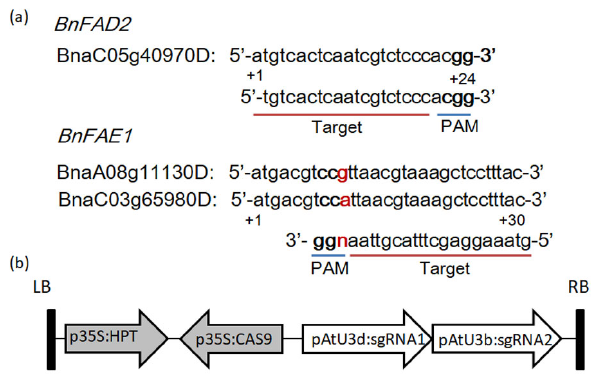
Figure 1. Target sequences of BnFAD2 and BnFAE1 genes and vector construction. ( a ) Sequences of the target sites in BnFAD2 and BnFAE1 genes are shown. PAM sequences (NGG) are indicated in bold font. ( b ) Schematic of the genome editing vector. The vector contains a hygromycin phosphotransferase (HPT) gene as a selection marker and the 35S promoter (p35S) to drive CAS9.